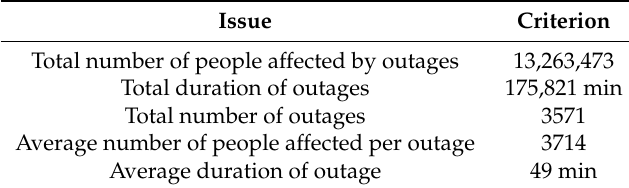
Table 5. A summary of the recorded outages in 2015 in US [54,56].